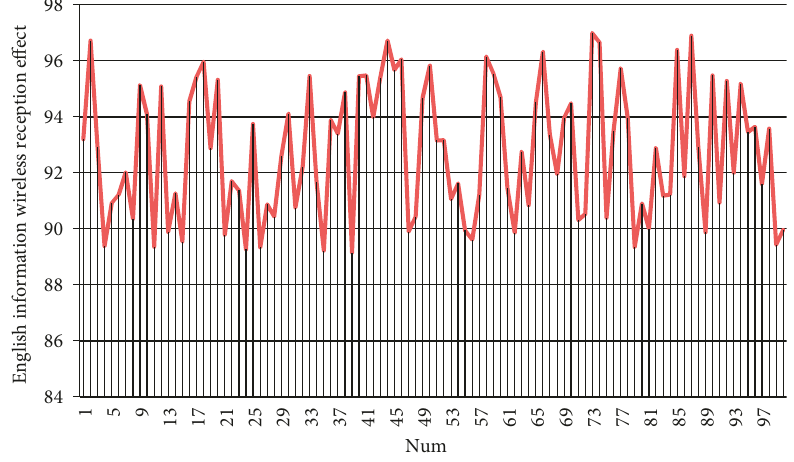
Figure 14: The effect of wireless reception of English information.